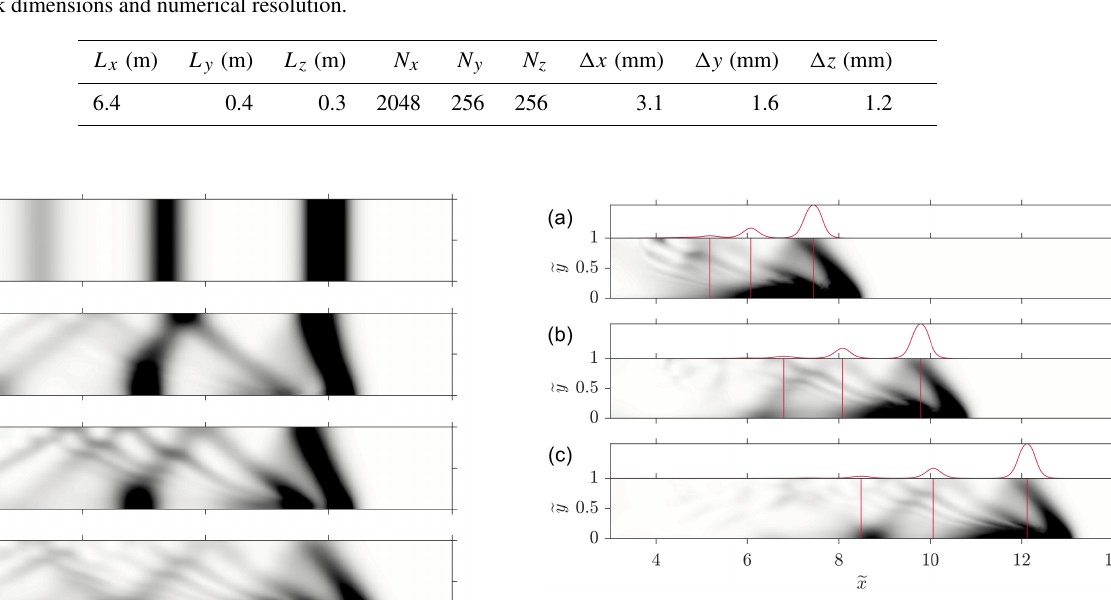
Table 3. Tank dimensions and numerical resolution.